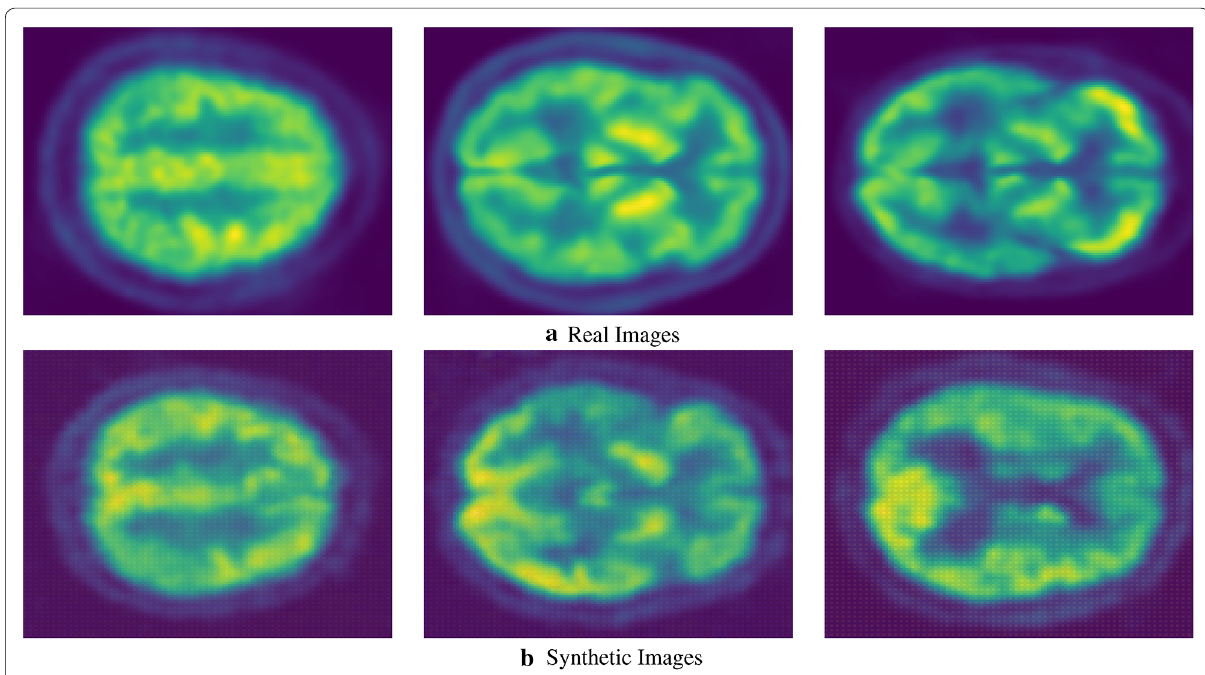
Fig. 8 Real and synthetic brain PET images of AD patient: a real b